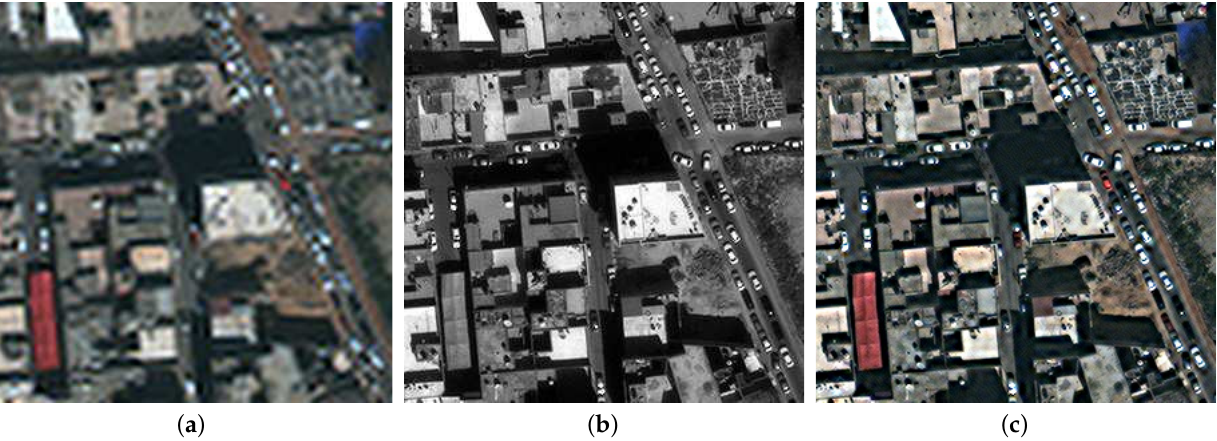
Figure 1. An example of pansharpening: ( a ) MS (interpolated) image; ( b ) PAN image; ( c ) fused image (namely, via the MBFE-BDSD-MLR method, presented in Section